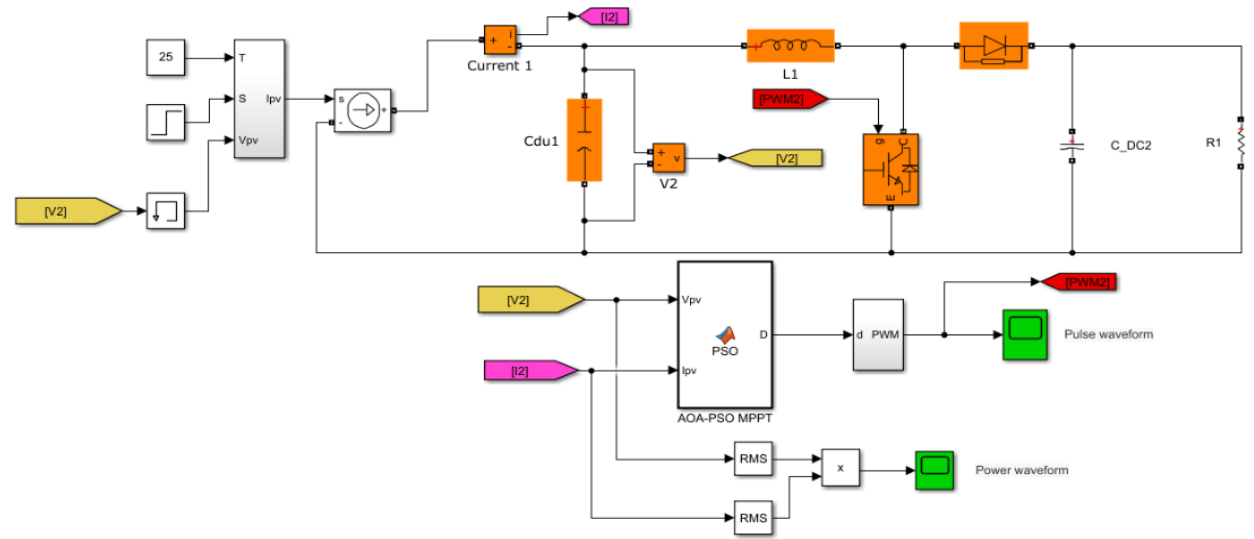
Figure 5. Overall control model of the photovoltaic power generation system.